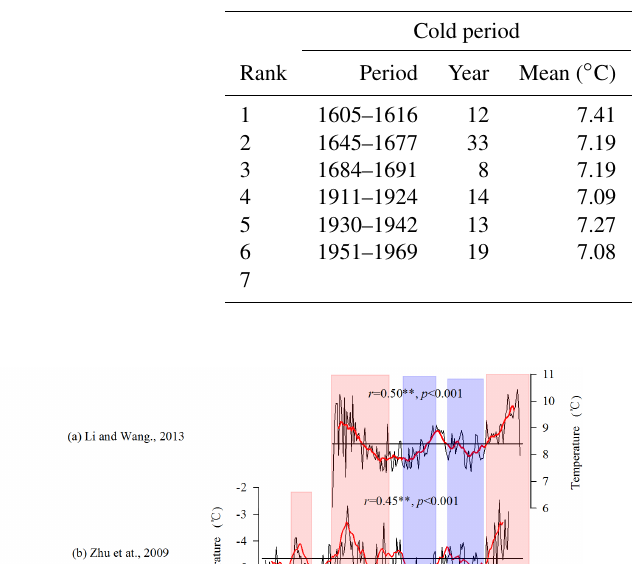
Table 4. Cold and warm periods based on the 11-year moving average April–July mean minimum temperature on Laobai Mountain during AD 1600–2013.